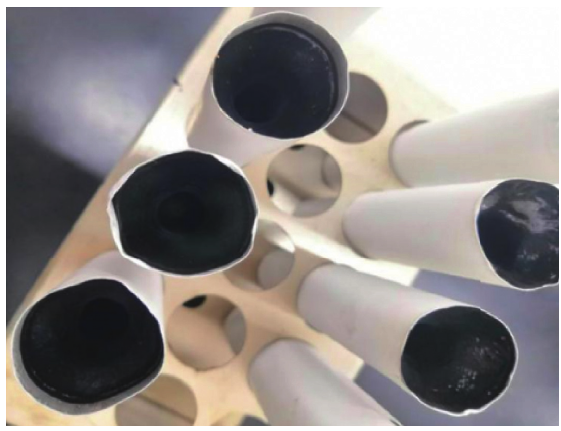
Figure 2: Aluminum pipe with modified